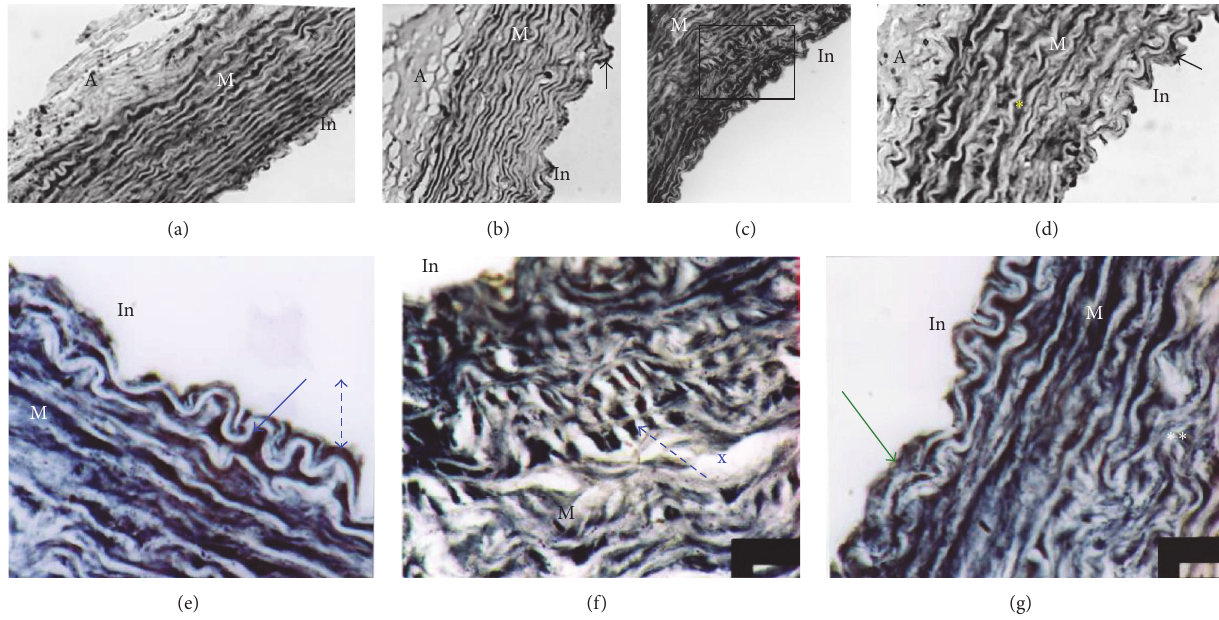
Figure 6: Aorta histochemistry of the different groups of female rabbits (Black Sudan B staining). (a) NPC, (b) PC, (c) NPMet, and (d) PMet. M: media, A: adventitia; In: intima; (a, b, c, d) are × 40 magnification; (e, f, g) are × 100 magnification of (c). (a) Control aorta. (b) Arrow shows blood cell agglutination. (c) The box indicates the area which is enlarged to (e, f, g). (d) Arrow shows endothelial elevation. (e) Lipid infiltration (arrow ) under intima and endothelial cell hypertrophy (dashed arrow) with important lipid load between blades. (f) Reorientation of media SMCs to the intimal direction (dashed arrow) and presence of amorphous material with diffuse appearance (X). (g) Intima thickness (arrow) with lipid load and collagen disorganization with elastic blades in tornado appearance ( ∗∗ ).